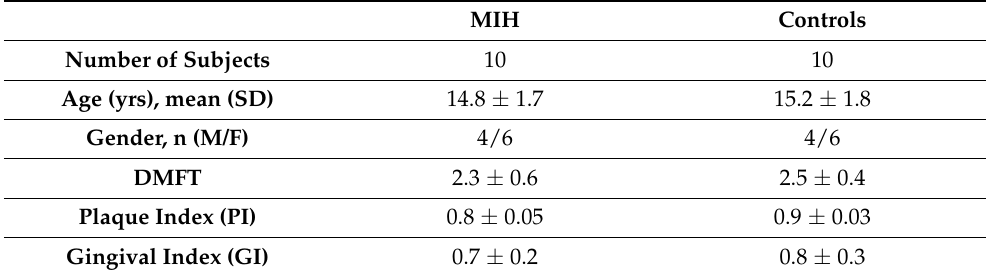
Table 1. Clinical characteristics and caries index (DMFT) of the studied population (* p -value < 0.05). Mean and standard deviation values (means ± SD) are reported.